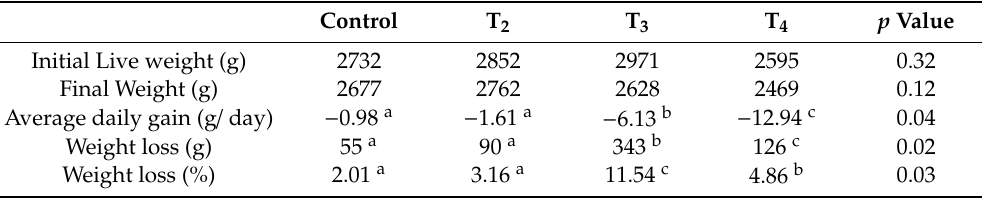
Table 3. Live weight of the agouti in different experimental feed groups.